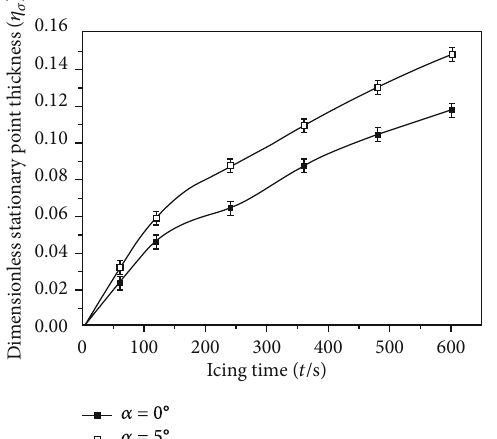
Figure 22: Dimensionless stationary point thicknesses in static